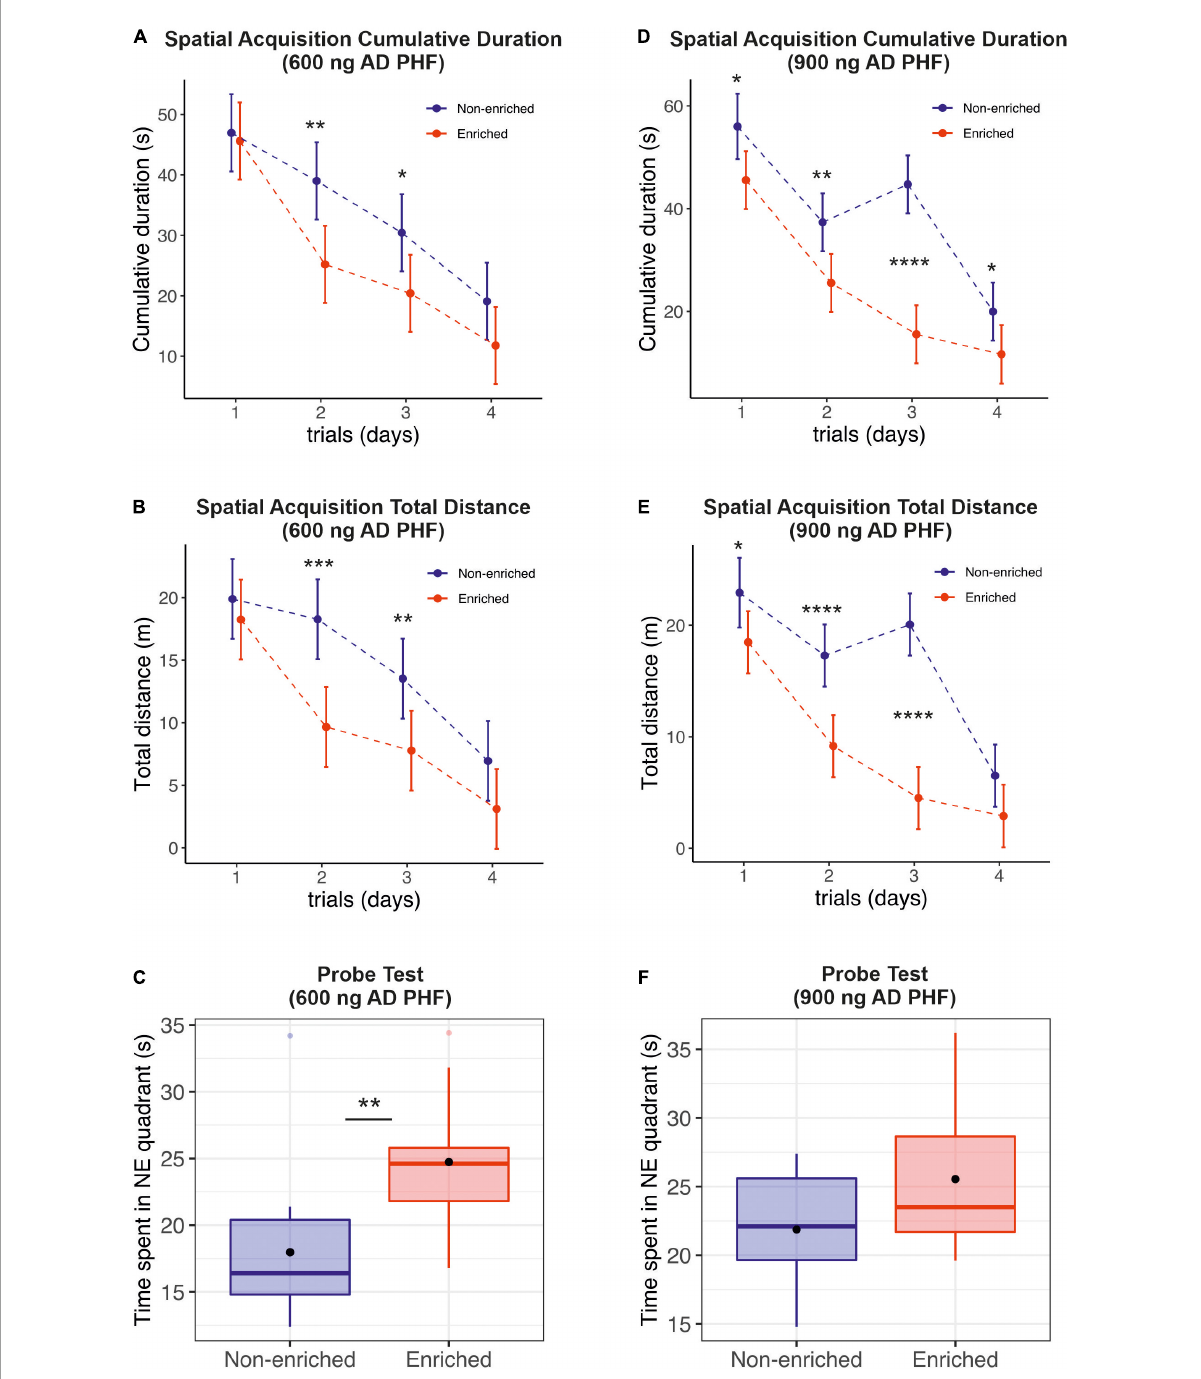
FIGURE2 Evaluation of the effect of enriched environment on spatial learning and reference memory in transgenic rats injected with different doses of AD PHF. Cumulative duration (A,D) , total distance (B,E) and the time spent in platform quadrant (NE) during the 60-s probe trial (C,F) were measured, 1st group injected with 600 ng AD PHF (A–C) , 2nd group injected with 900 ng AD PHF (D–F) . Rats exposed to enriched environment needed less time to find the platform position (A,D) and traveled less total distance (B,E) than sedentary animals. Rats injected with lower dose (600 ng) of AD PHF and exposed to enriched environment spent significantly more time in platform quadrant than their non-enriched counterparts (C) . A similar trend was observed in the 2nd group of animals injected with higher dose of AD PHF, but the difference was not statistically significant. Graphs (A,B,D,E) represent mean and 95% of the mean of the respective experimental groups. Graphs (C,E) denote median, quartiles, with whiskers showing quartiles ± 1.5 × IQR. Dots denote arithmetic mean. * p < 0.05, ** p < 0.01, *** p < 0.001, **** p <